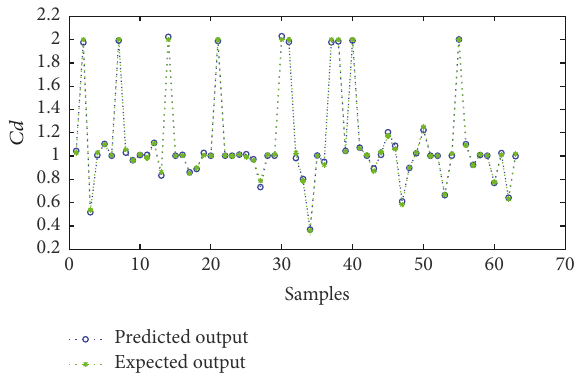
Figure 18: Comparisons of the drag ratio of the follower AUV by BPNN and CFD.